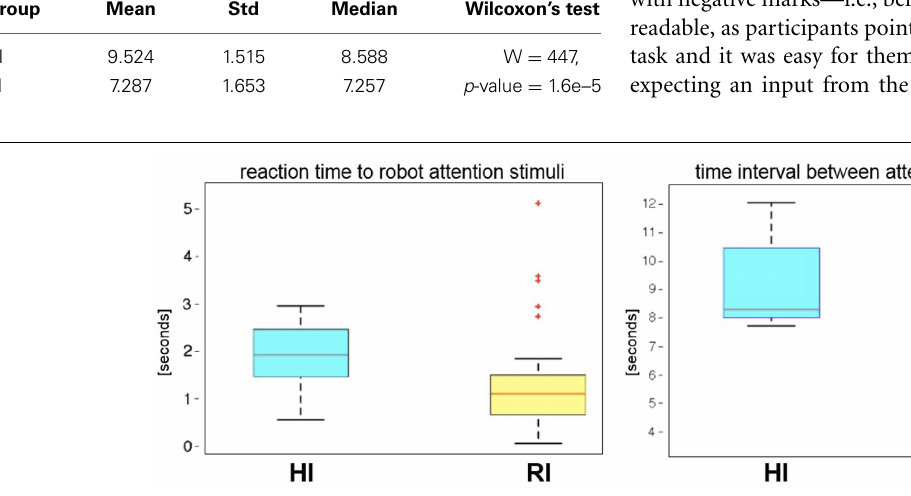
Table 2 | Time interval (seconds) between consecutive robot attention stimuli (utterances) during verification phase.